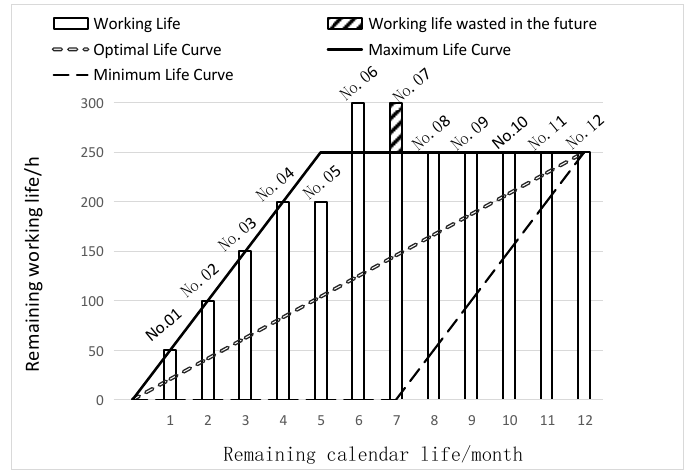
Figure 3. Echelon usage diagram with M < N